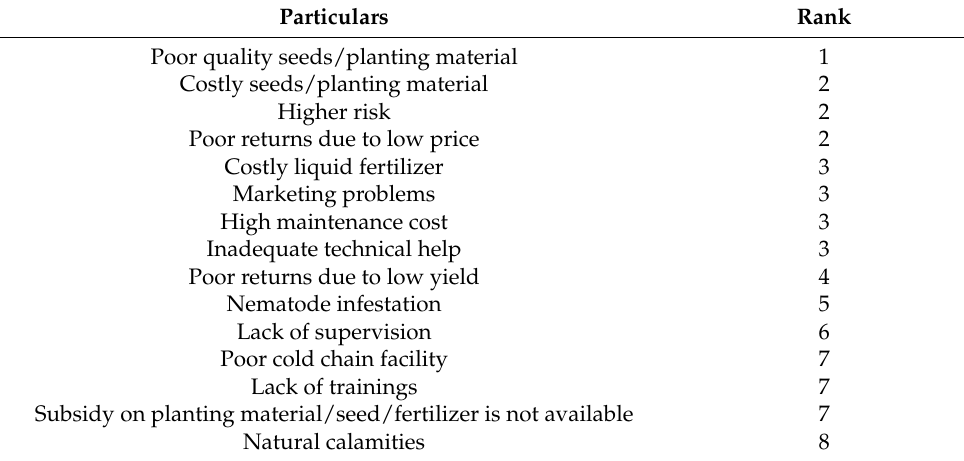
Table 25. Reasons for discontinuation of protected